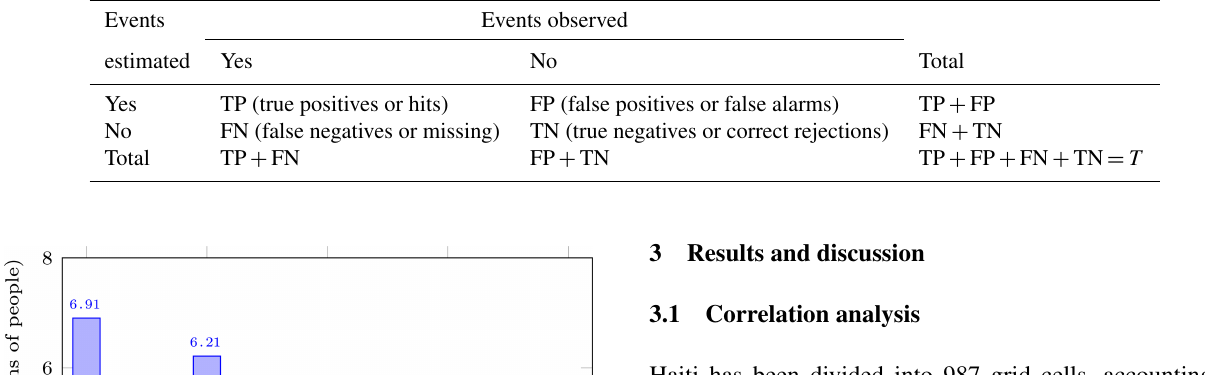
Table 6. Contingency table for the deterministic estimates of a series of binary events (Joliffe and Stephenson, 2012). Events